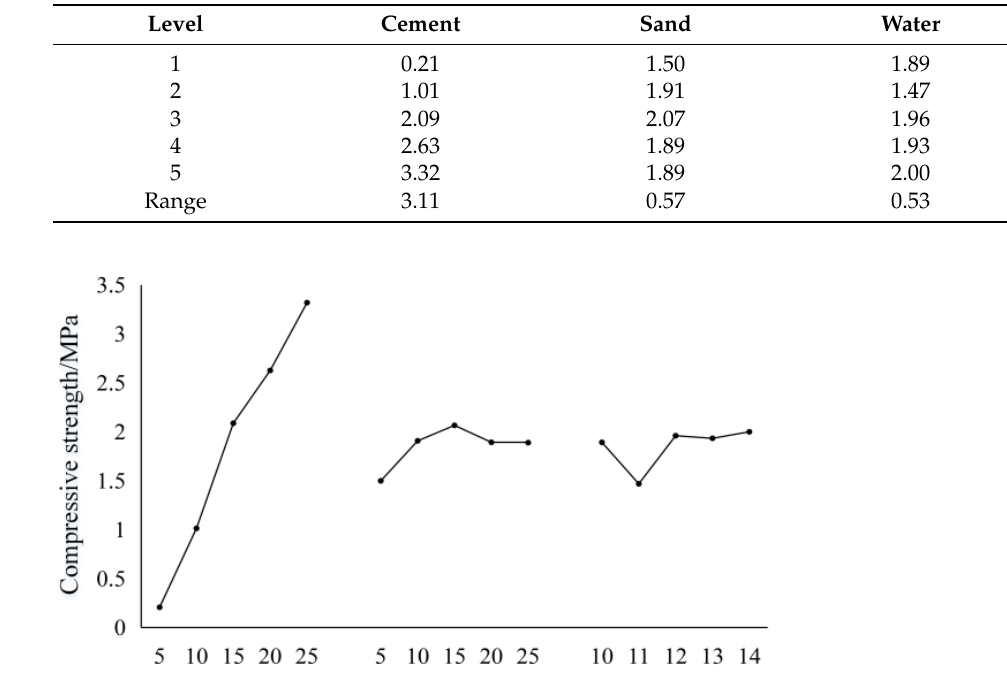
Table 6. Range analysis for the uniaxial compressive strength of simulated coal samples. Level